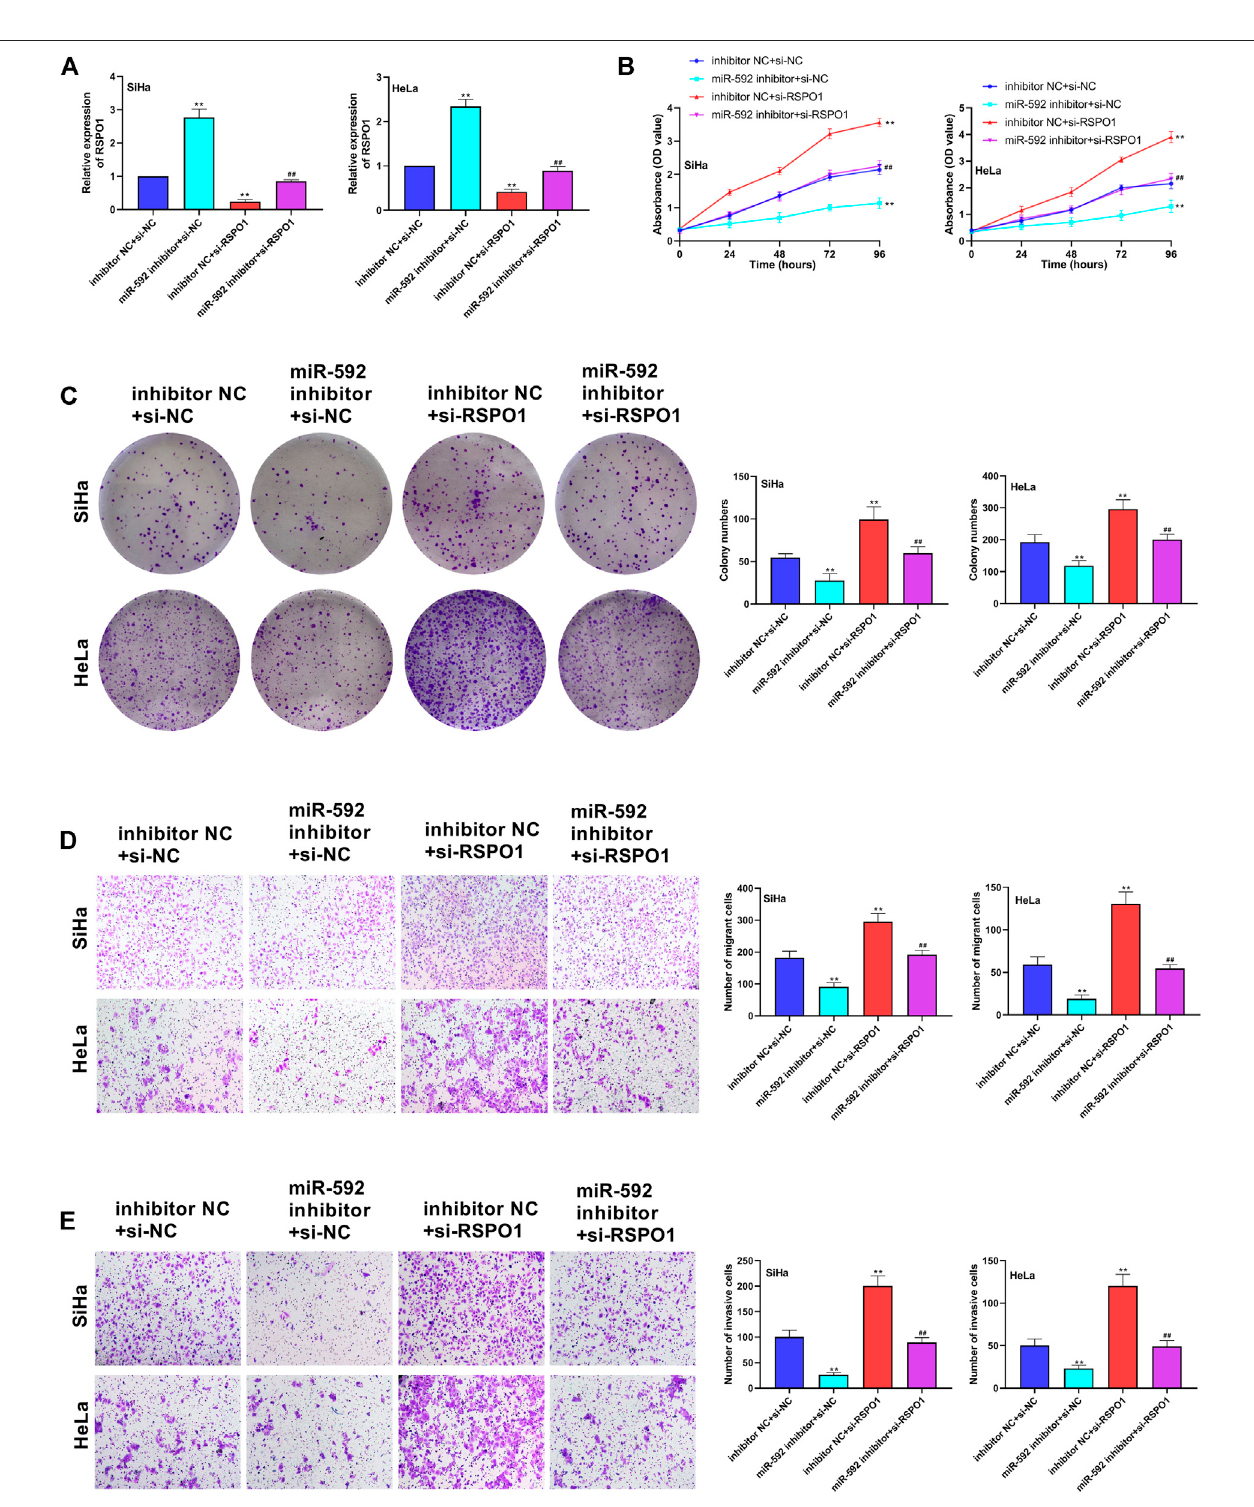
FIGURE6 | LowexpressionofmiR-592inhibitedproliferation,migrationandinvasionofCCcellsbyregulatingRSPO1. (A) ExpressionofmiR-592aftertransfectionofmiR- 592 inhibitor, si-RSPO1 or miR-592 inhibitor + si-RSPO1 was detected by qRT-PCR; (B) The proliferation ability of SiHa and HeLa after transfected with miR-592 inhibitor, si- RSPO1ormiR-592inhibitor+si-RSPO1wasdetectedbyCCK-8; (C) ThecolonyformationabilityofSiHaandHeLaaftertransfectedwithmiR-592inhibitor,si-RSPO1ormiR-592 inhibitor + si-RSPO1 was measured by colony formation assay; (D) The migration ability of SiHa and HeLa after transfected with miR-592 inhibitor, si-RSPO1 or miR-592 inhibitor+si-RSPO1wasdetectedbyusingtranswellassay; (E) TheinvasionabilityofSiHaandHeLaaftertransfectedwithmiR-592inhibitor,si-RSPO1ormiR-592inhibitor+si- RSPO1wasdetectedbyusingtranswellassay.Measurementdatawereexpressedasmean ± standarddeviation.Thecellexperimentisrepeatedthreetimesindependently.** p < 0.01, compared with inhibitor NC + si-NC group; ## p < 0.01, compared with miR-592 inhibitor + si-NC or inhibitor NC + si-RSPO1 group (A – E) .